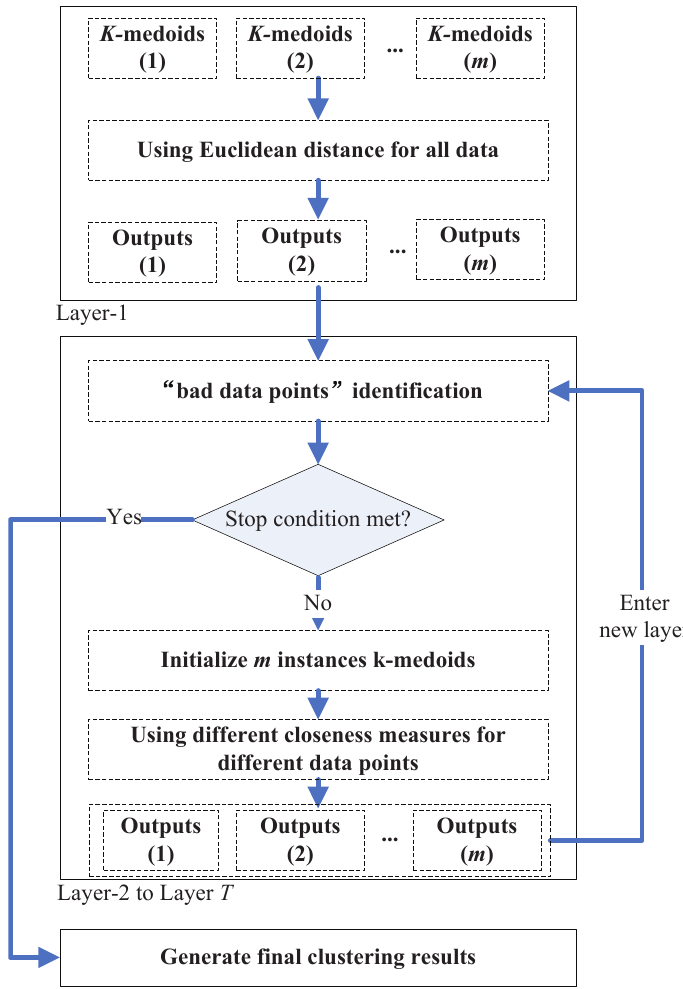
Figure 12. Illustration of the implementation of the proposed